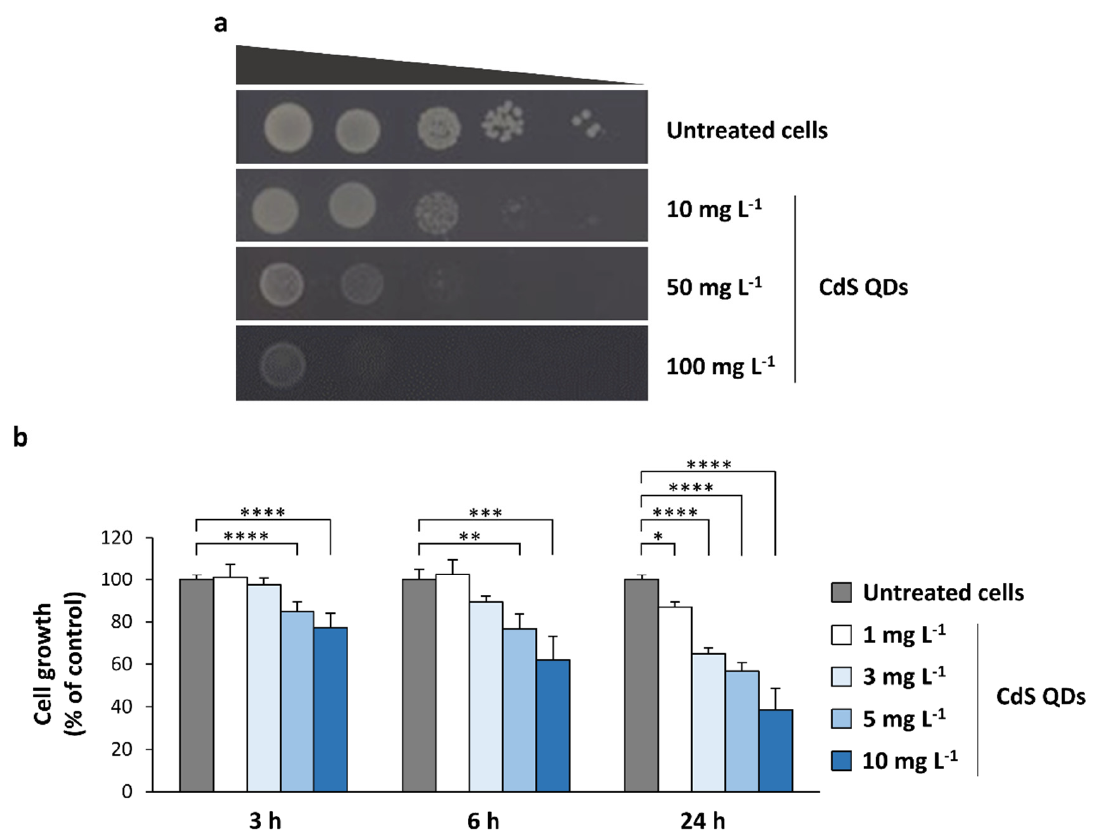
Figure 1. CdS QDs negatively affect the growth of Z239-6B-6B diploid strain in fermentative condi- tions. ( a ) Spot assay. Ten-fold serial dilutions (starting from OD 600 = 1) of Z239-6B-6B diploid strain were seeded on SD agar plates supplemented with CdS QDs (10–100 mg L − 1 ). Control (untreated) cells were also spotted on SD agar plates (without ENMs). Plates were incubated at 28 ◦ C for 48 h. ( b ) Growth curves were recorded for 24 h in SD medium with (or without) the supplementation of CdS QDs (1–10 mg L − 1 ). The values shown in the histograms are the mean ( ± standard deviation) of three independent experiments performed in triplicate. Significance was determined by one-way ANOVA with Dunnett’s multiple-comparisons test. * p < 0.05; ** p < 0.01; *** p < 0.001; **** p <